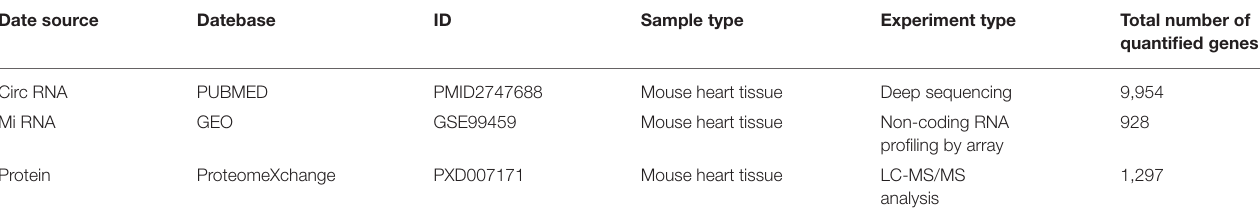
TABLE 1 | Basic information of the 3